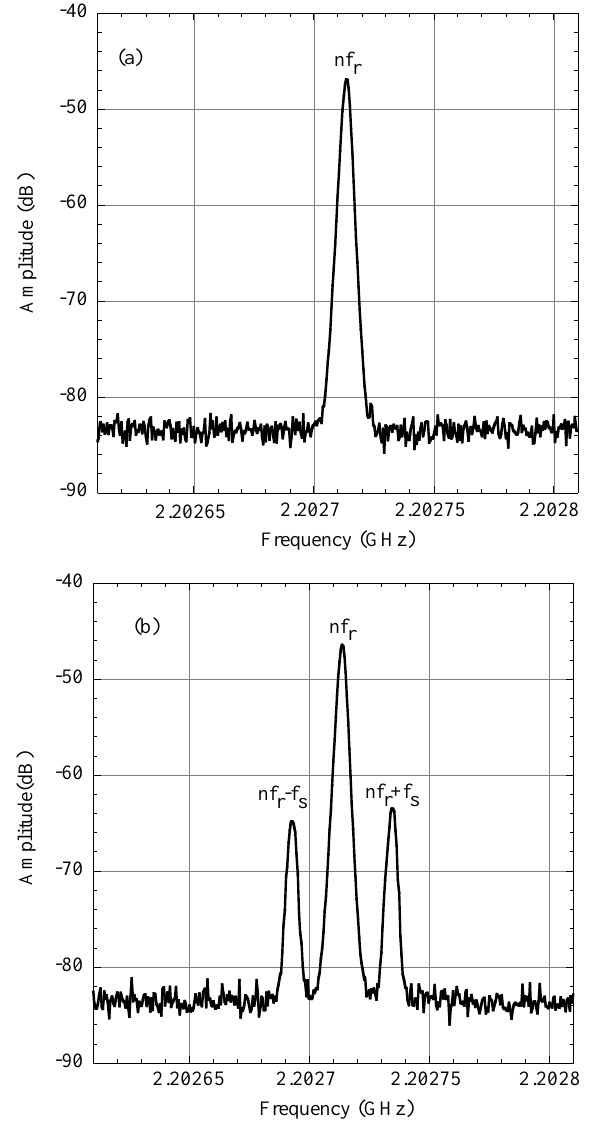
FIG. 21. The spectrum analyzer beam spectra centered on a rotation harmonic at 2.202 71 GHz (a) without the instability and (b) with the instability present. The synchrotron frequency for CESR is f s (cid:8) 20